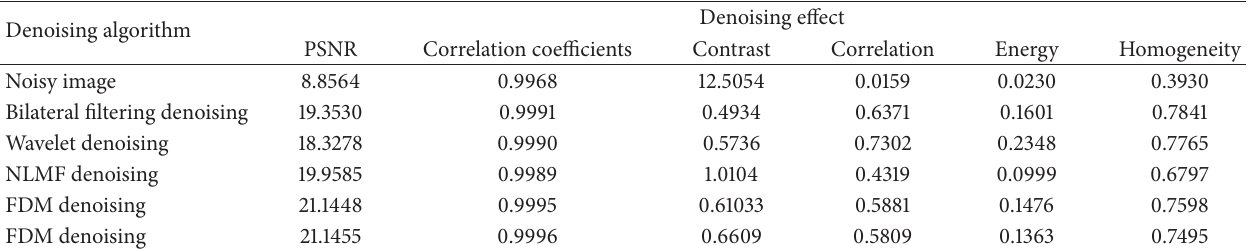
Figure 7: Denoising effects of meteorite crater texture-rich moon satellite remote sensing image, when white Gaussian noise, salt, and pepper noiseandspecklenoiseareaddedtogether.(a)Originalcleanimage,(b)noisyimage(addswhiteGaussiannoise(itsstandardvarianceis0.02), salt and pepper noise (its noise density is 0.2), and speckle noise (its standard variance is 0.1) to the original clean image, PSNR = 8.8564 ), (c) denoised image of bilateral filtering denoising [88, 89, 93], (d) partial enlarged details of 1/4 party of (c) red box, (e) denoised image of wavelet denoising [92, 93], (f) partial enlarged details of 1/4 party of (e) red box, (g) denoised image of NLMF denoising [94, 95], (h) partial enlarged details of 1/4 party of (g) red box, (i) denoised image of FDM denoising ( V 1 = 1.75 , V 2 = 2.75 , V 3 = 1.05 , and Δ𝑡 = 10 −10 ), (j) partial enlarged details of 1/4 party of (i) red box, (k) denoised image of FDM denoising ( V 1 = 2.25 , V 2 = 2.5 , V 3 = 1.25 , and Δ𝑡 = 10 −10 ), and (l) Partial enlarged details of 1/4 party of (k) red box. Table 4: Denoising effects on texture-rich meteorite crater remote sensing image of moon satellite, when white Gaussian noise, salt and pepper noise and speckle noise are added